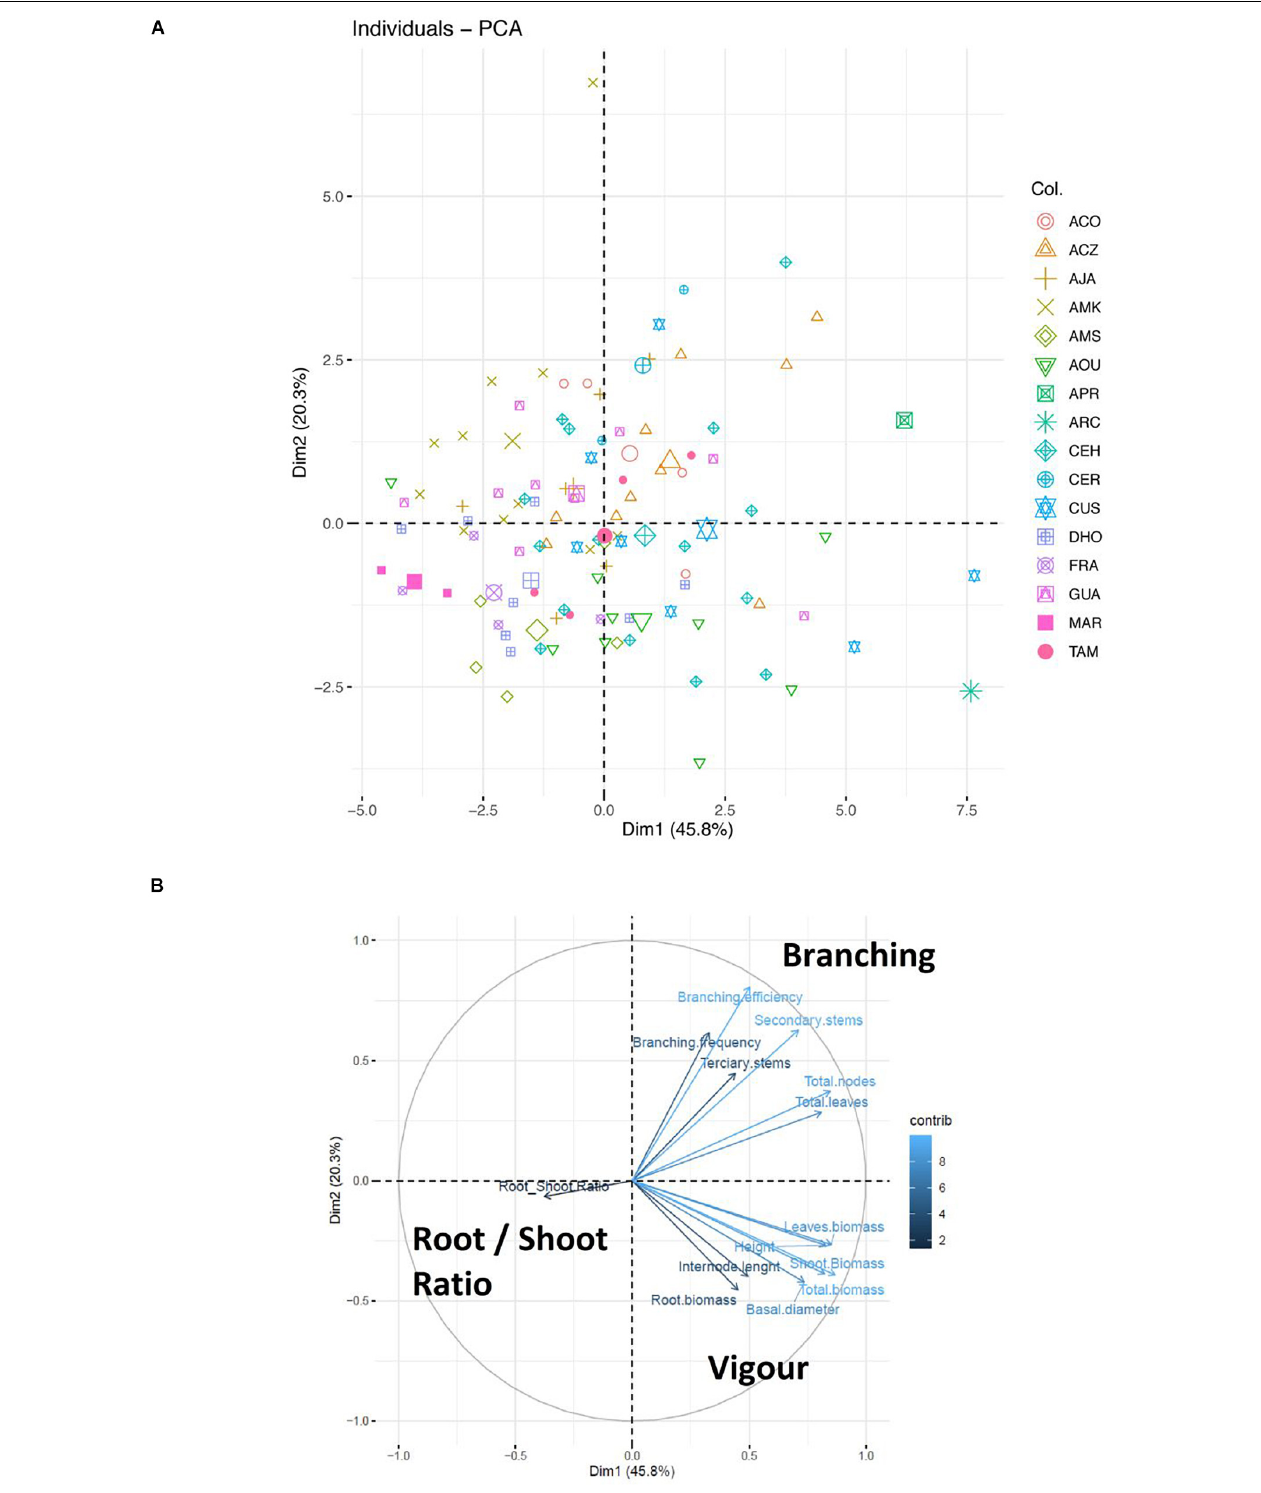
FIGURE 3 | Principal Component Analysis (PCA) of morphological parameters of wild olive subspecies. Data concerning morphological parameters were converted into a matrix of numerical values. The missing data were interpolated using the “Mice” package as a preliminary step to the calculation of the main components using “Prcomp.” In (A) the two main components of variability, explaining here 66.5% of the total variability, were identified using the “Fviz_eig (res.pca)” algorithm and the results were plotted in a graphic. In (B) the contribution of each variable is depicted in the two main components previously represented in (A) .